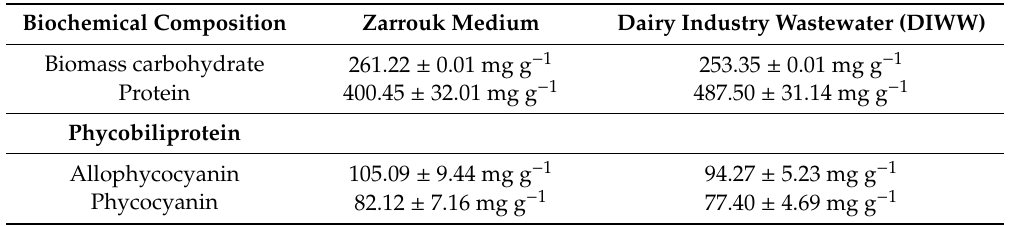
Table 1. Biomass carbohydrate, protein, and phycobiliprotein (allophycocyanin [APC] and phycocyanin [PC]) of Arthrospira platensis in batch cultures. Values are average ± SD ( n = 3).